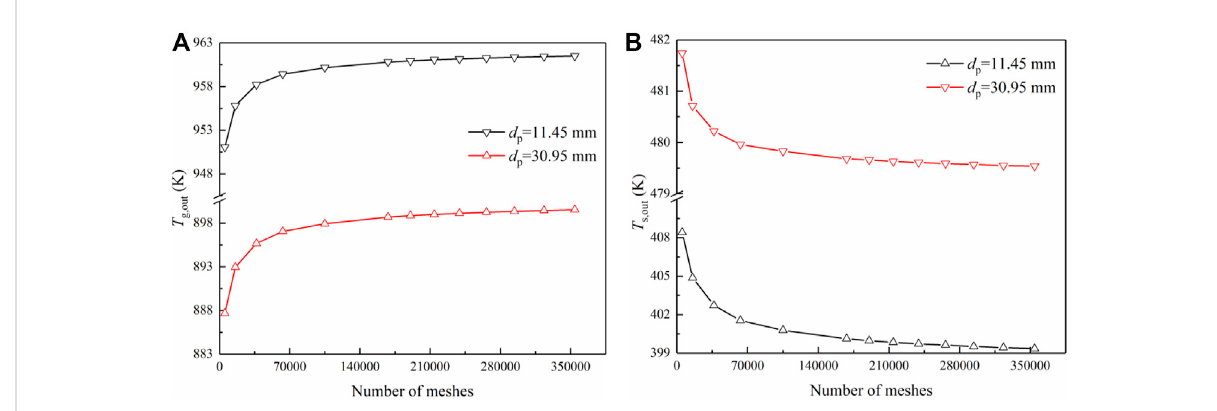
FIGURE 3 Variation of the temperature with the number of meshes: (A) Outlet temperature of the gas T g , out ; (B) Outlet temperature of the sinter T s , out .